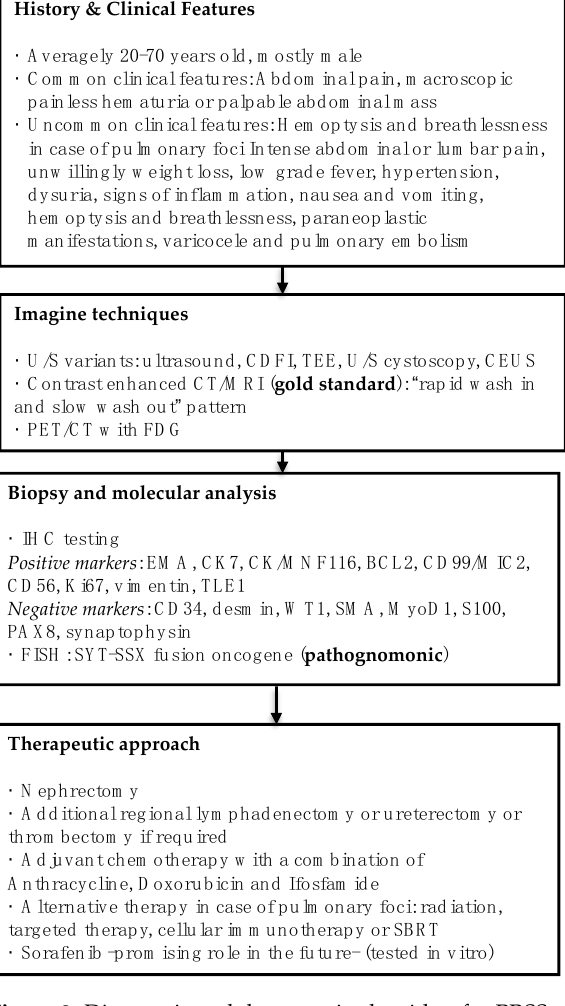
Figure 2. Diagnostic and therapeutic algorithm for PRSS.